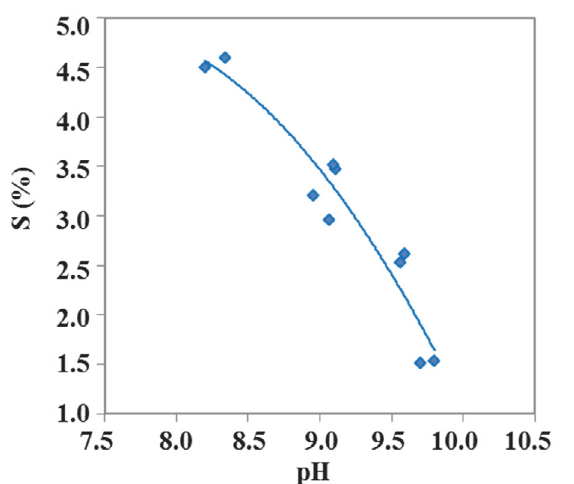
Figure 8 . Interaction between sulfur contained in the BNC and pH suspension, mini-column (Stage 01).